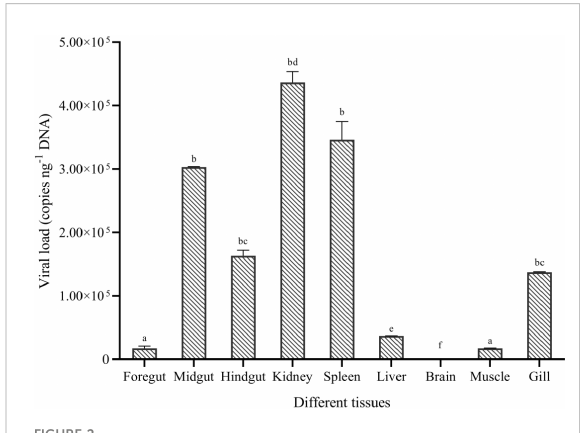
FIGURE 2 Viral replication in different tissues of gibel carp ( C. auratus gibelio ) challenged by CyHV-2 using the quantitative real-time PCR method. One-way ANOVA was conducted with SPSS 17.0 software. Different letters mean signi fi cant di ff erence among tissues ( p <